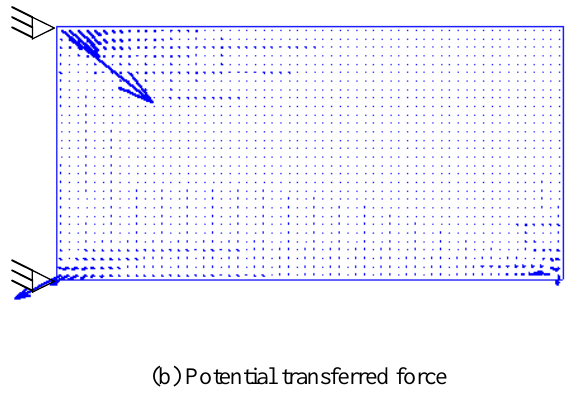
Fig. 7. Transferred and potential transferred force to th reaction points